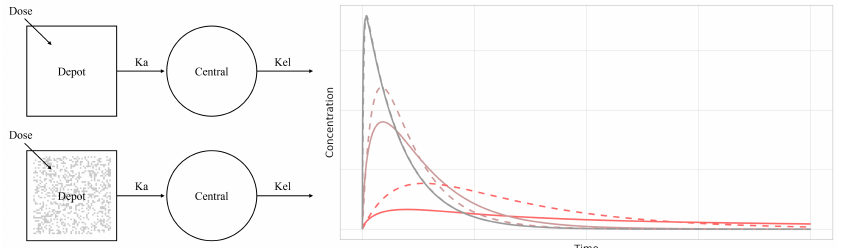
Figure 1. Classical pharmacokinetic model scheme of one-compartment model for oral absorption (upper left scheme, Ka: absorption rate, Kel: elimination rate), pharmacokinetic model with fractal dimension (lower left scheme) and simulation for drug concentration with fractal-like reaction rate to the absorption process (right plot, dashed lines: concentration of classical model; solid lines: concentration of fractal-like rate model with homogeneity exponent of 1/3, red lines: Ka = 0.01, brown lines: Ka = 0.1, gray lines: Ka =